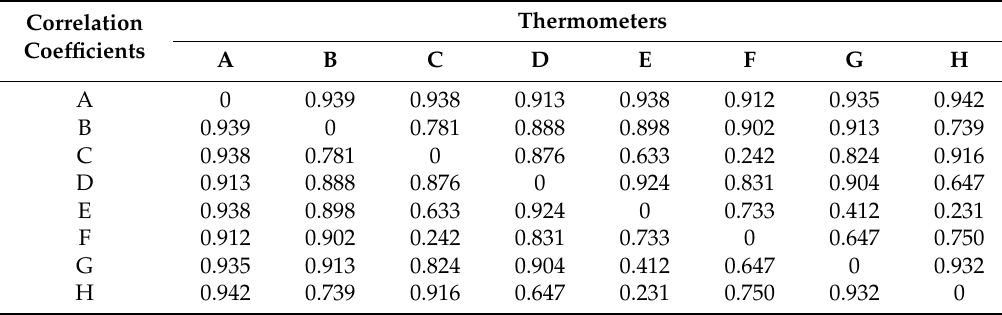
Table 3. The correlation coefficients between the RLG bias and the temperature gradient array.